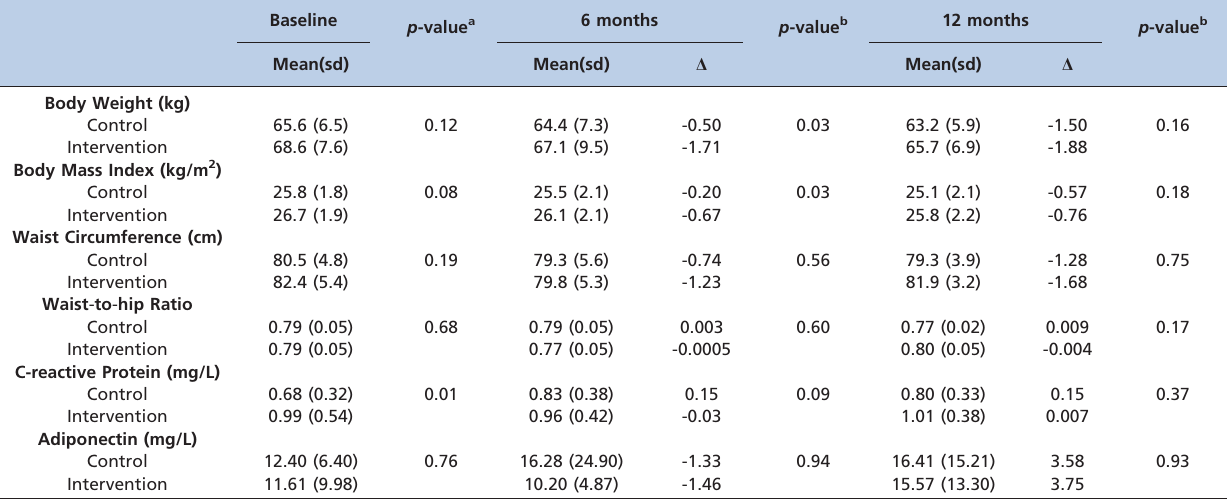
Table 1 - Crude means (standard deviation) and adjusted changes from baseline ( D ) for anthropometric measurements and inflammatory markers during the follow-up by intervention group (controls = 28 and home-based exercise= 26).